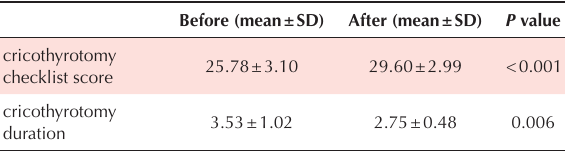
Table 1. Cricothyrotomy duration and the checklist a score of the